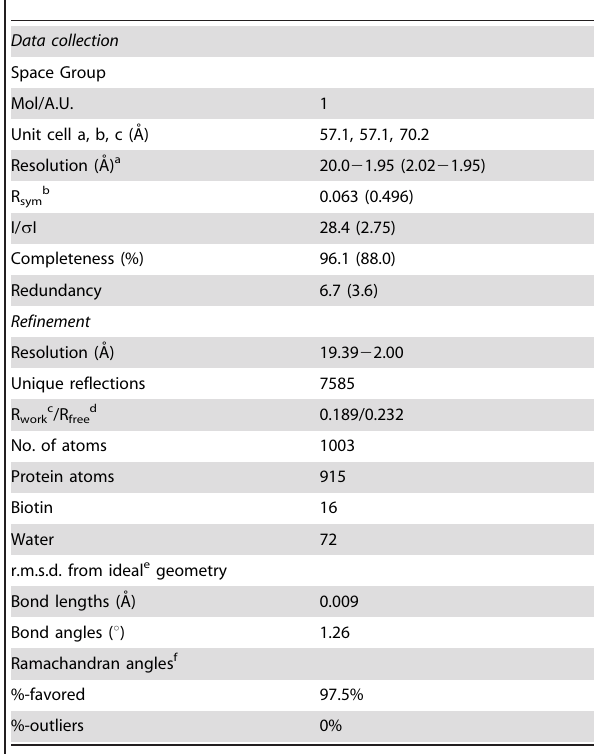
Table 4. Crystallographic